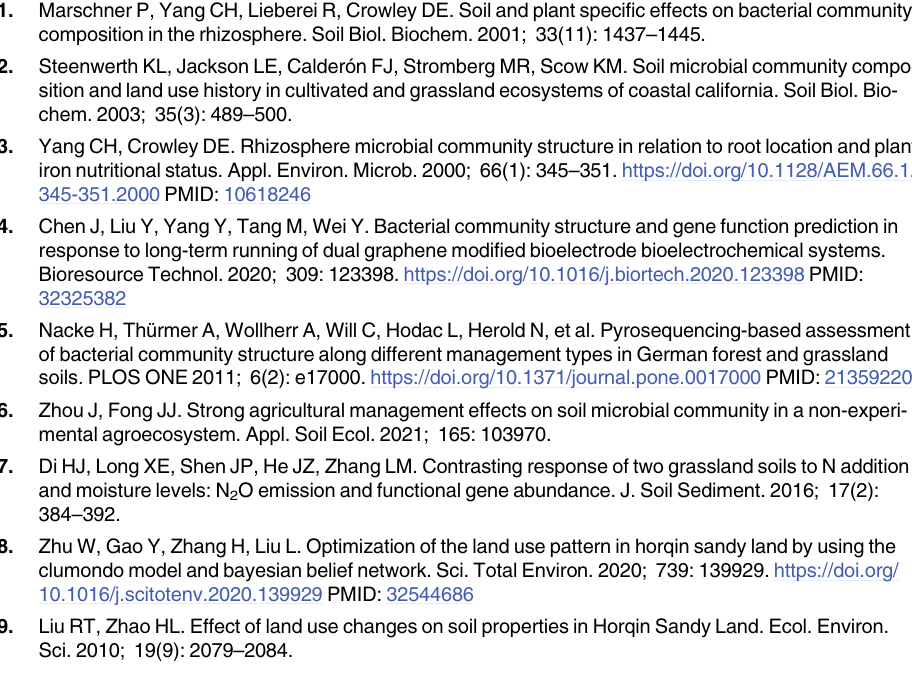
S1 Table. Analysis of soft rock and sand compound soil physical and chemical properties.